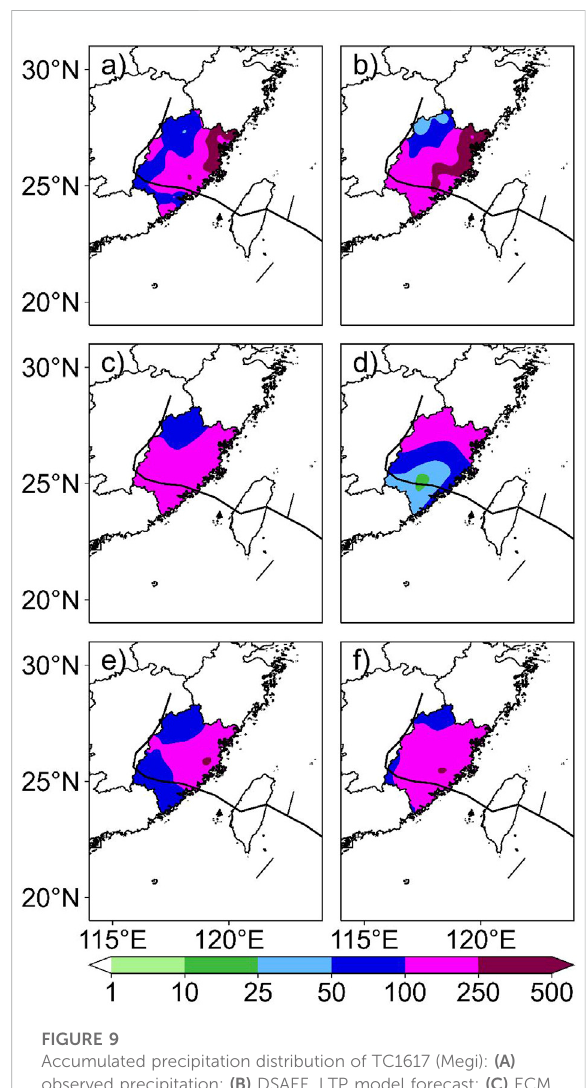
FIGURE 9 Accumulated precipitation distribution of TC1617 (Megi): (A) observed precipitation; (B) DSAEF_LTP model forecast; (C) ECM forecast; (D) GRP forecast; (E) mSH forecast; (F) NCP forecast.The black solid line is the observed